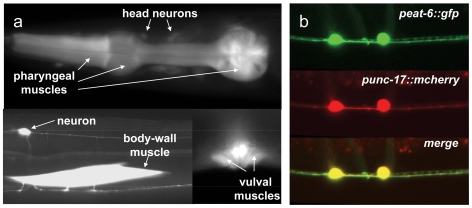

eat-6 is expressed in muscles and neurons.(a) Photomicrographs of animals expressing GFP driven by the eat-6 promoter. (b) Top, a photomicrograph of GFP driven by the eat-6 promoter; middle, a photomicrograph of mCherry driven by the unc-17 promoter; and bottom, merge of the top and middle images.